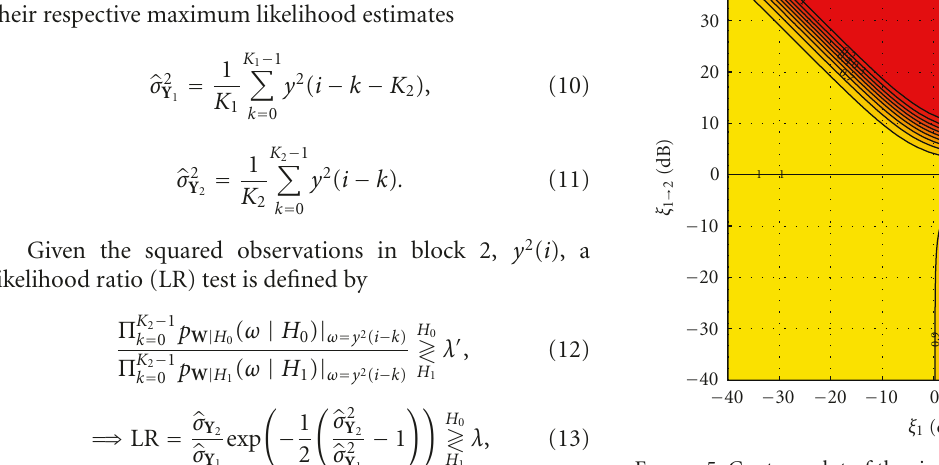
Figure 5: Contour plot of the simplified likelihood ratio (16). The noise is assumed to be stationary ( σ 2 N SNR in block 1, ξ 1 → 2 the step of the a priori SNR at the transition from block 1 to